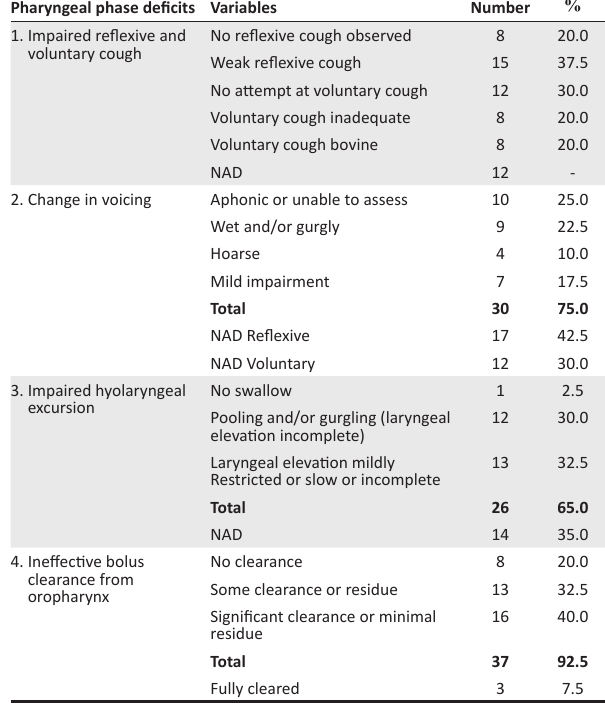
TABLE 3: Predominant deficits affecting the safety of the swallow ( N = 40).